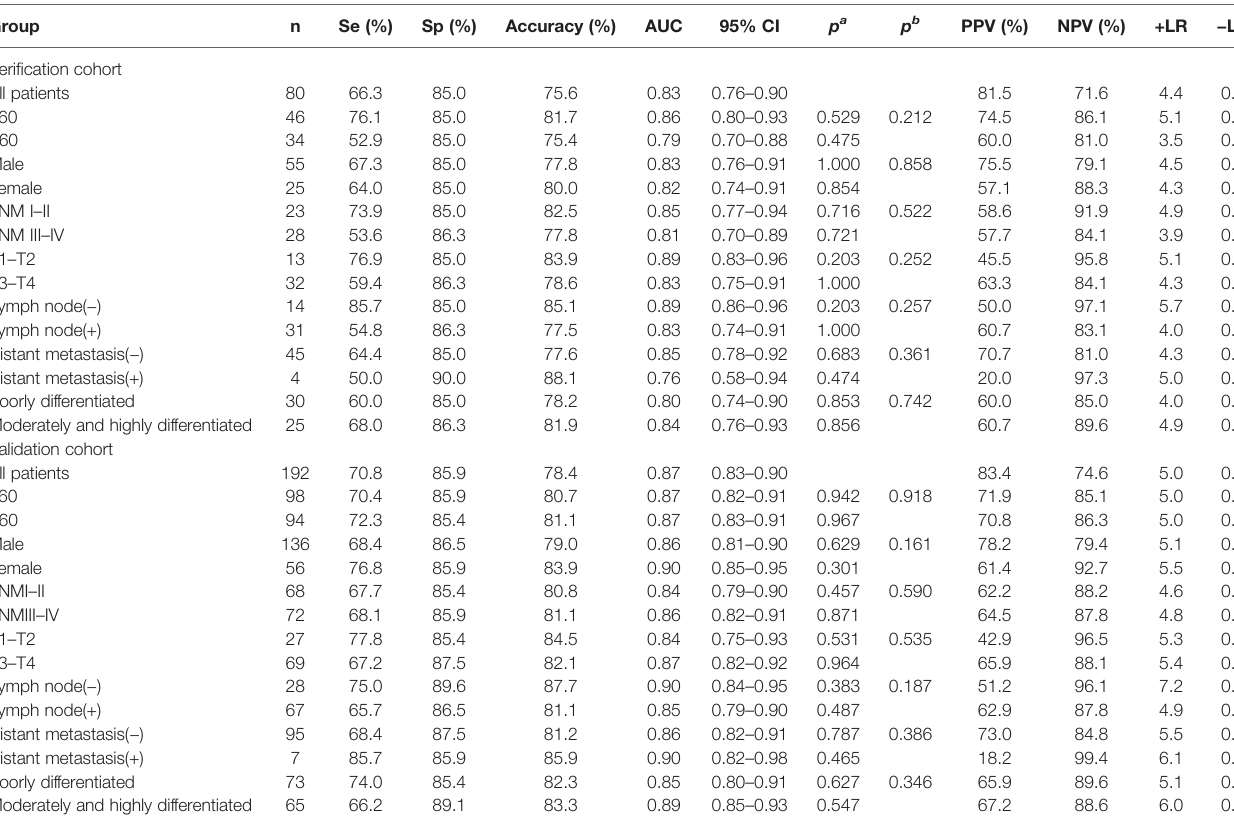
TABLE 3 | Diagnostic value of the anti-TAAs autoantibodies panel for gastric cancer (GC) patients with different